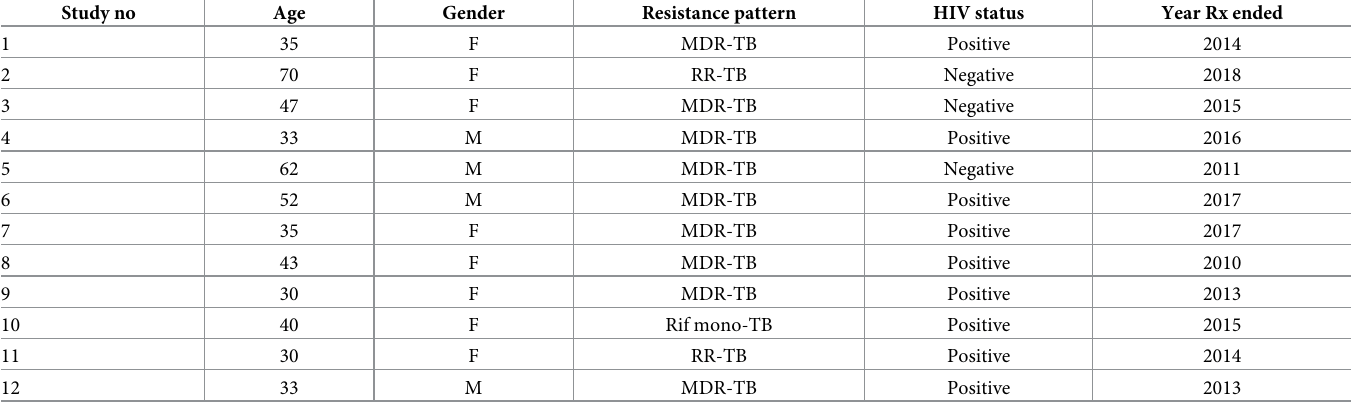
Table 1. Details of study